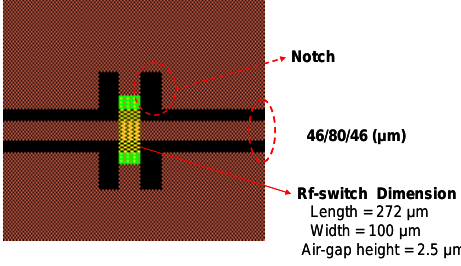
Figure 7: Notch introduced capacitive type shunt RF-switch